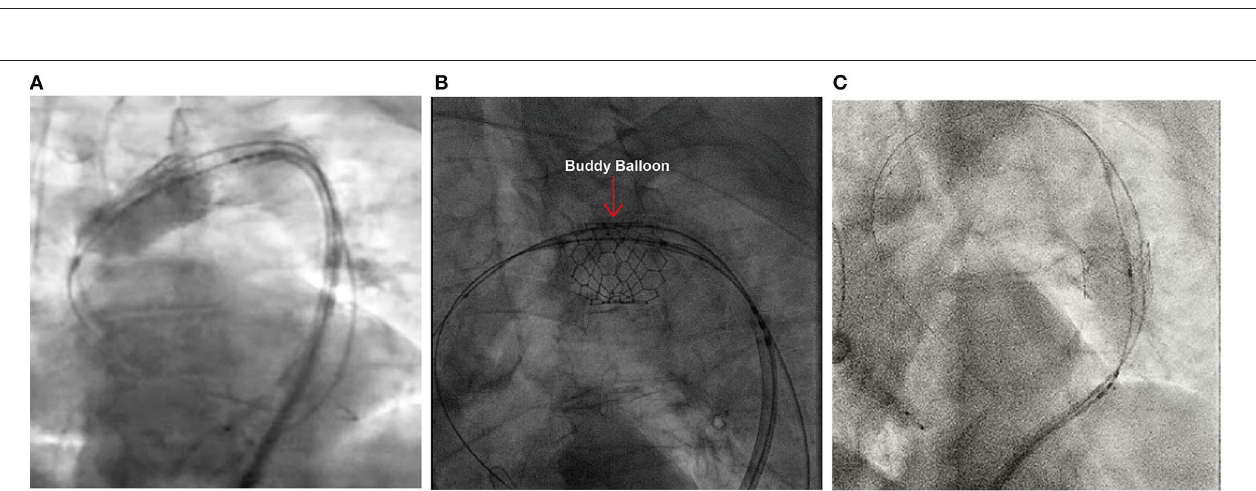
FIGURE 2 | Repositioning of the Embolized Sapien 3 THV. (A) Inflation of the deploying balloon to pull the whole system back. (B) Compression of the Sapien 3 THV by inflating a “buddy balloon.” (C) Anchoring of the embolized Sapien 3 THV into the descending